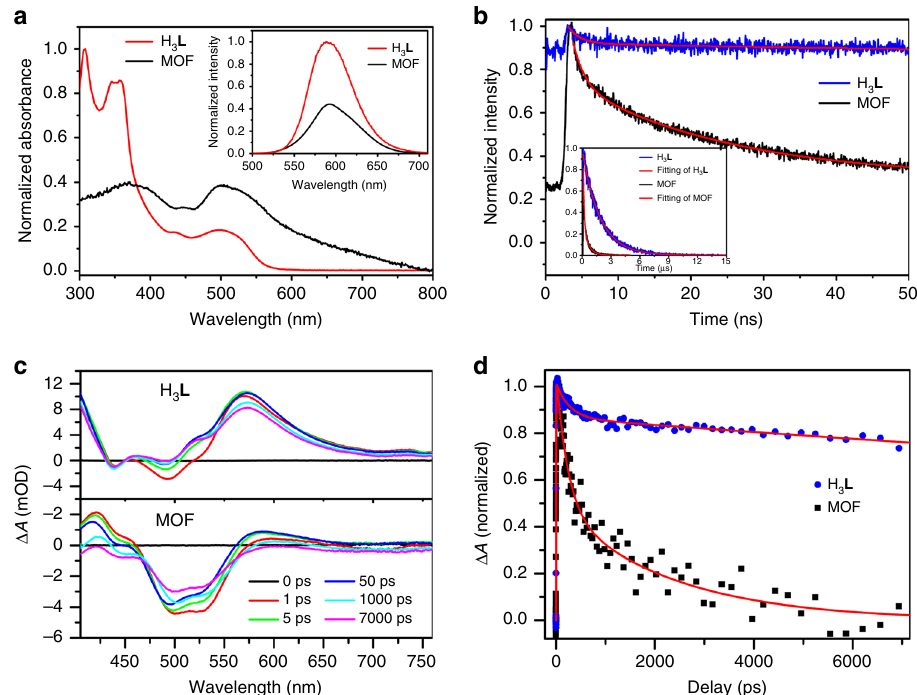
Fig. 4 Spectroscopic evidence for effective electron transfer process. a Normalized UV – vis of Eu-Ru(phen) 3 -MOF and H 3 L in DMF. Inset: Emission spectra of Eu-Ru(phen) 3 -MOF and H 3 L ( λ ex = 465 nm). b Normalized luminescence decay traces of Eu-Ru(phen) 3 -MOF and H 3 L over the fi rst 50 ns ( λ ex = 377 nm). Inset: Decay transients measured at 630 nm ( λ ex = 465 nm). c Transient absorption spectra of Eu-Ru(phen) 3 -MOF and H 3 L at various time delays, and d corresponding kinetic traces at 604 nm